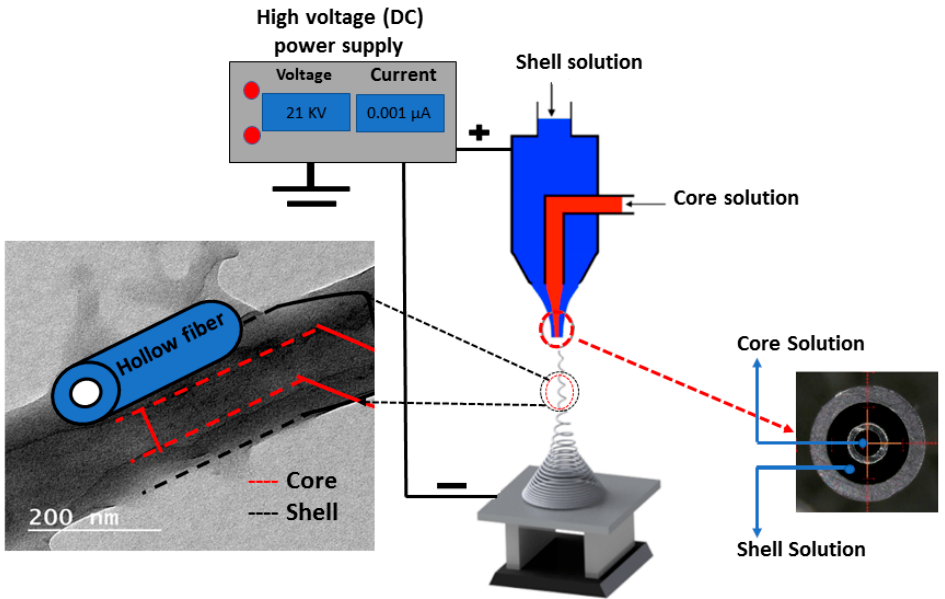
Figure 1. Scheme illustrating the electrospinning technique setup for engineering a coaxial nanofiber membrane.